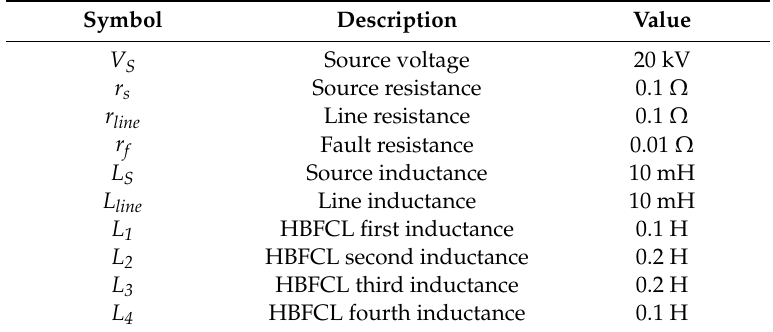
Table 1. The values of the H bridge type fault current limiter (HBFCL) parameters.